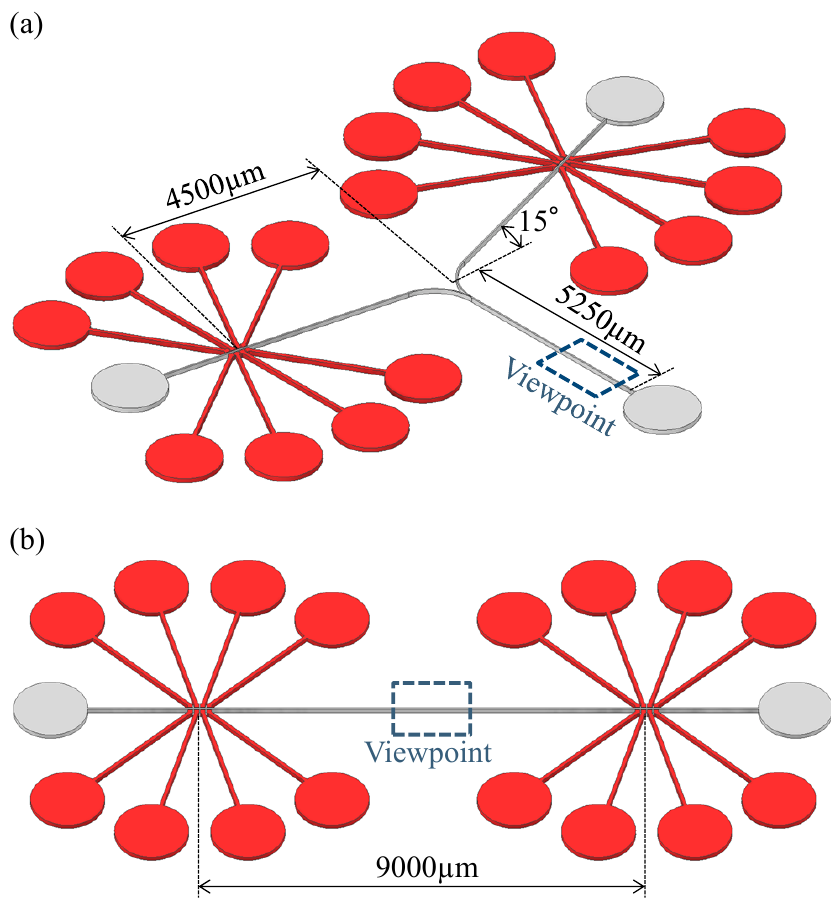
Figure 4. ( a ) Paralell pump. ( b ) Series